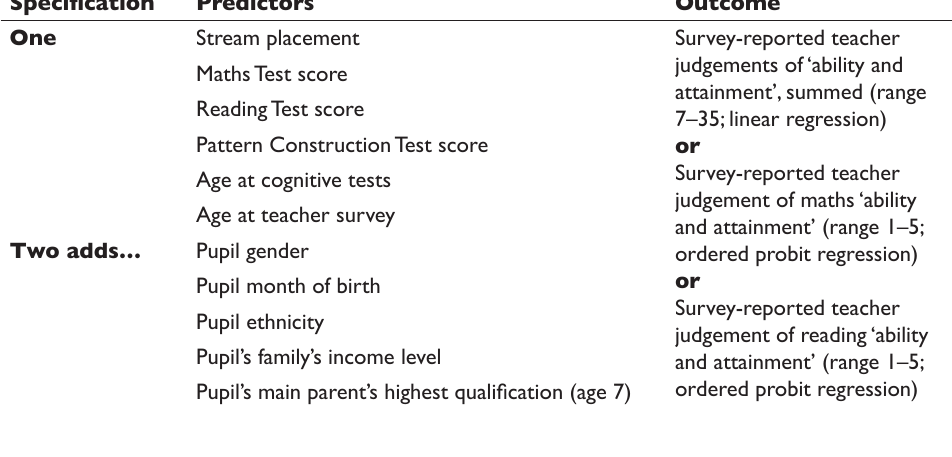
Table 4: Cumulative specifications for models with each survey-reported teacher judgement as outcome